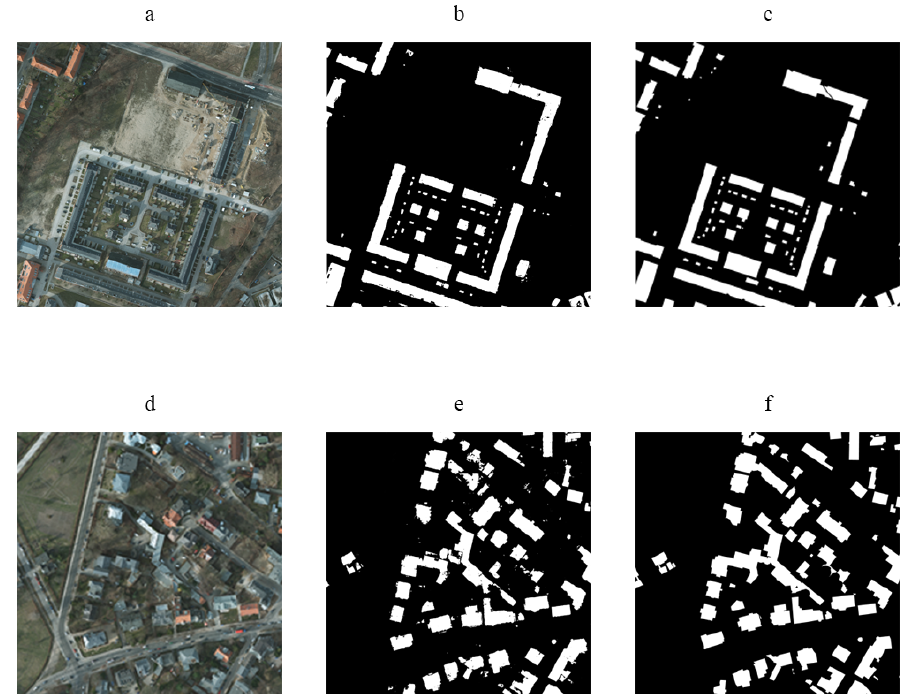
Figure 7. Two examples of results obtained on two entire 6000 × 6000 pixel tiles from the Potsdam dataset. ( a ) RGB TOP image of Tile 1. ( b ) HAFNetE classification result on Tile 1. ( c ) Ground Truth map for Tile 1. ( d ) RGB TOP image of Tile 2. ( e ) HAFNetE classification result on Tile 2. ( f ) Ground